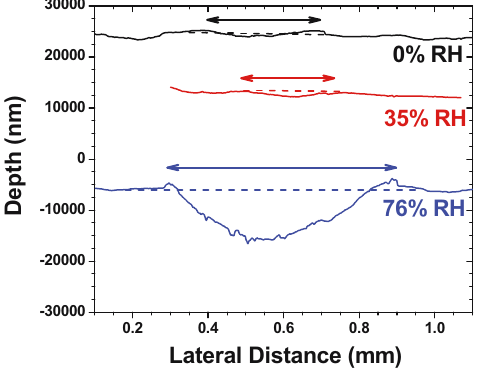
Figure 12: Wear track pro fi les obtained at di ff erent relative humidity ( RH ) for a specimen made at T = 170°C. Wear tracks are perpendicular to the textured lines of